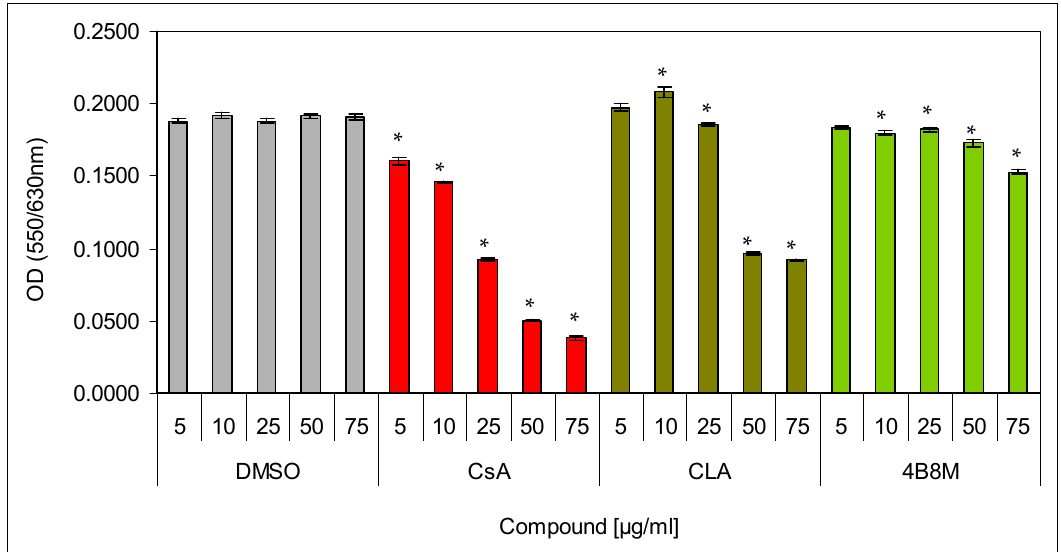
Figure 1. Toxicity of the peptide against mouse splenocytes: Splenocytes, resuspended in the culture medium, were cultured for 24 h in a cell culture incubator with the preparations at indicated concentrations. Cell survival was determined by the MTT (93-[4-dimethylthiazol-2-yl]-2,5-diphenyltetrazolium bromide) colorimetric method. Mean values OD ± SE for respective groups are presented; * dimethylsulfoxide (DMSO) vs. compounds p < 0.05 (ANOVA).